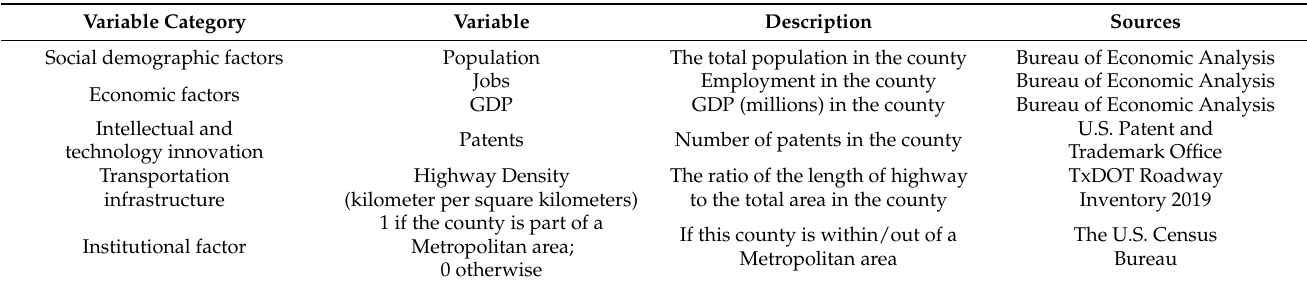
Table 2. Selected major drivers of urban